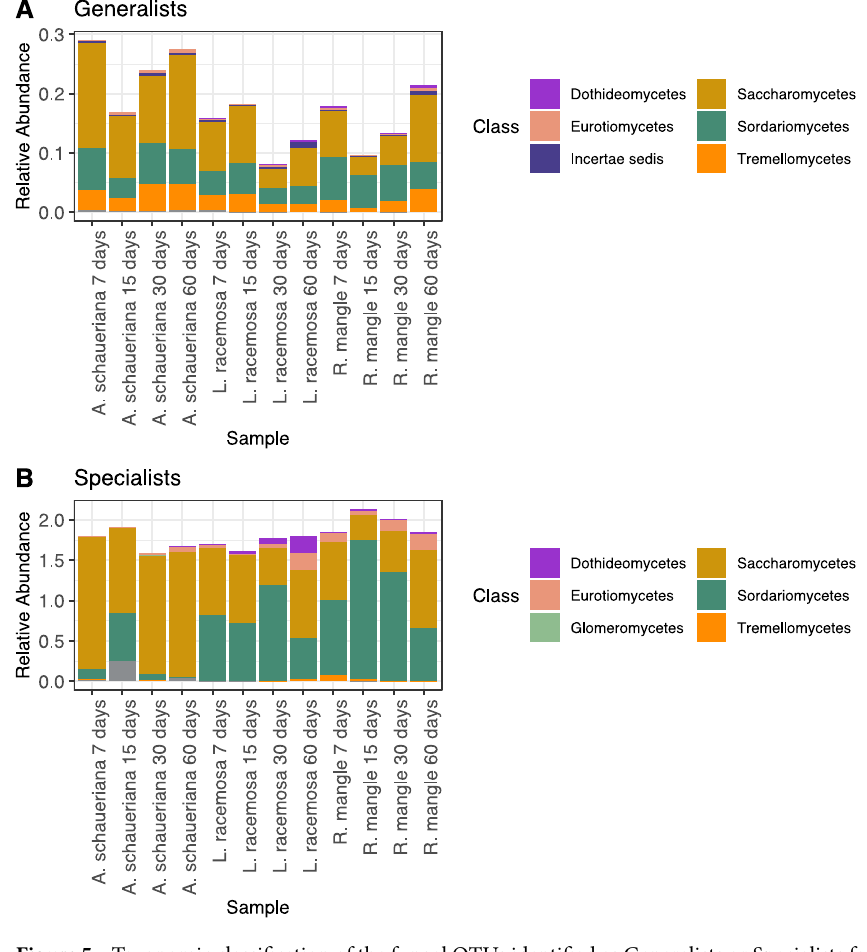
Figure 5. Taxonomic classification of the fungal OTUs identified as Generalists or Specialists found during the decomposition of mangrove leaves.